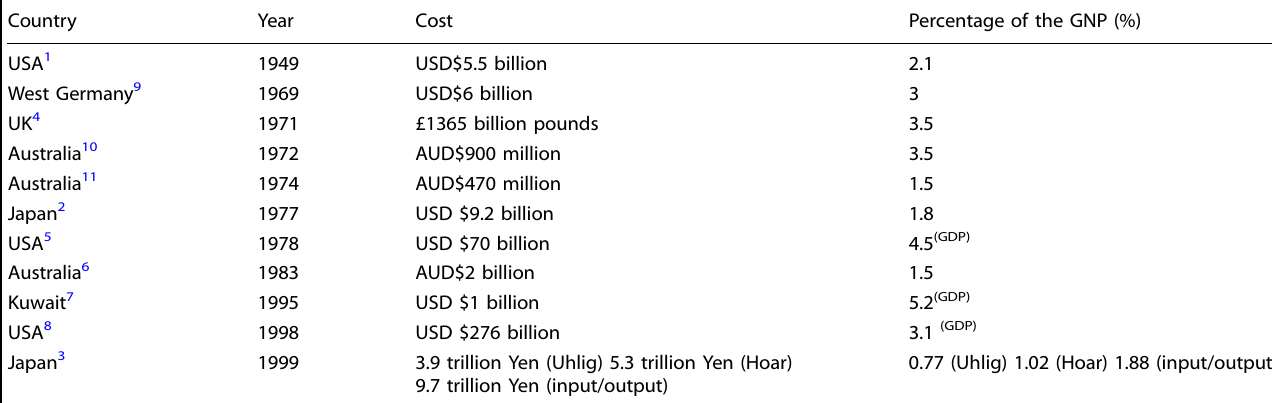
Table 1. The cost of corrosion studies undertaken by speci fi c countries Country